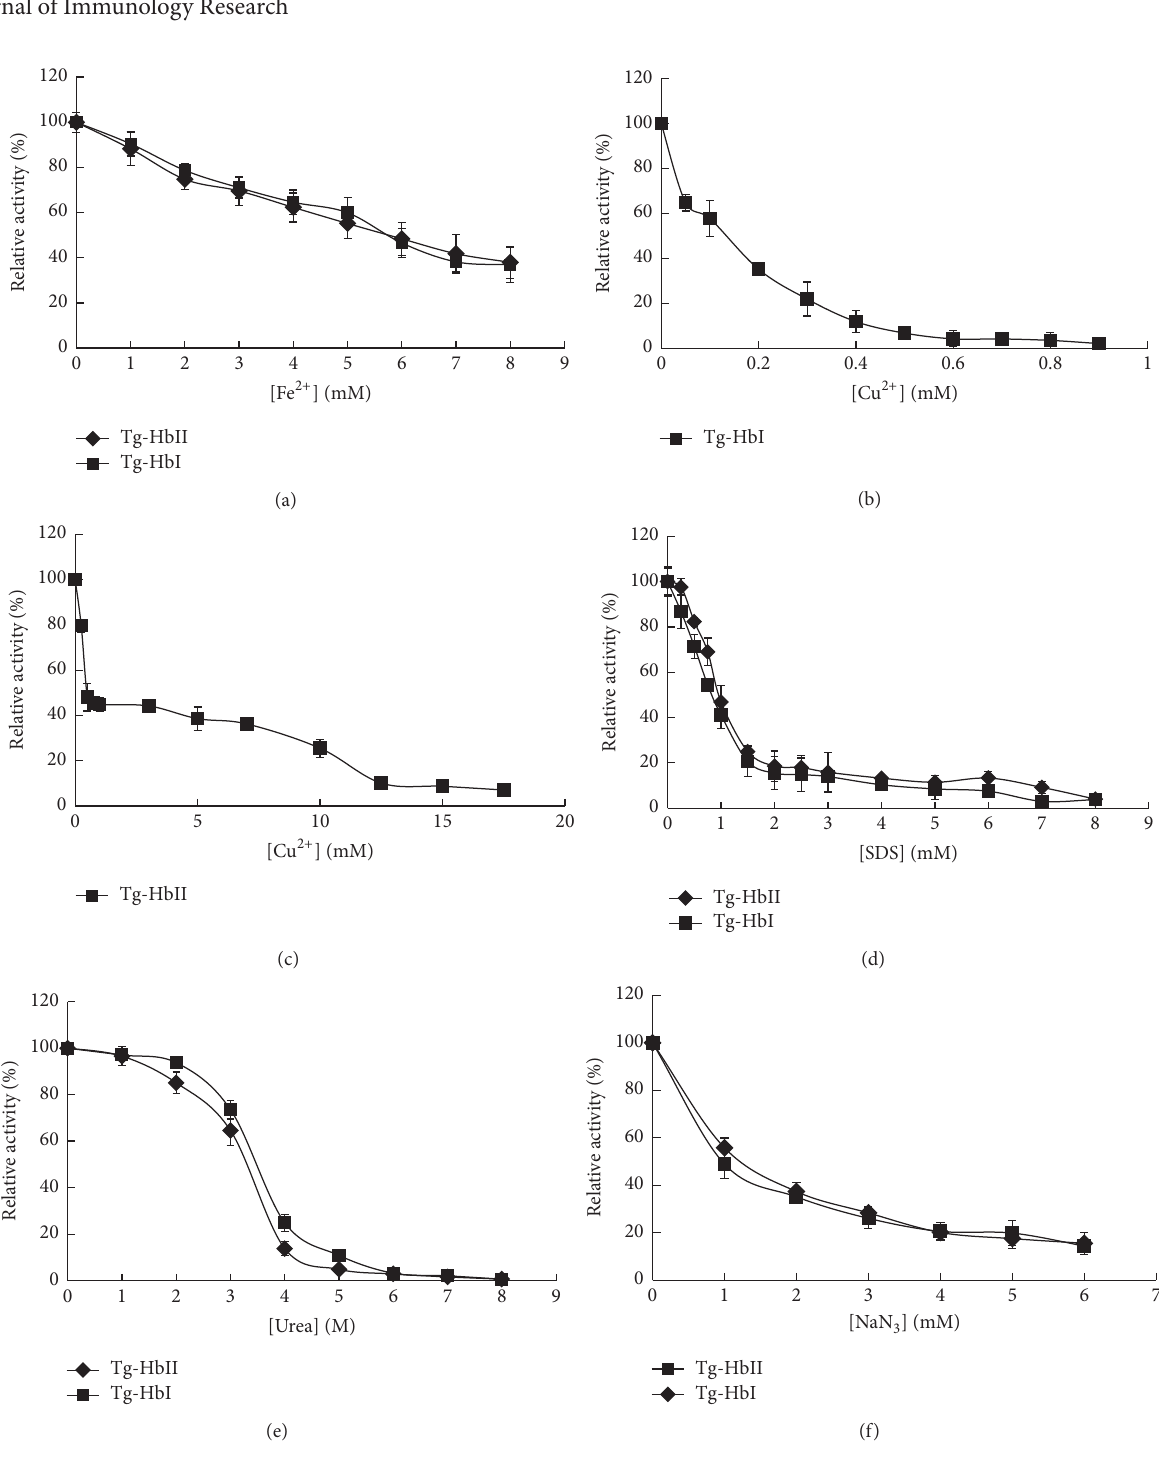
Figure 4: The effect of chemicals on Tg-Hb peroxidase